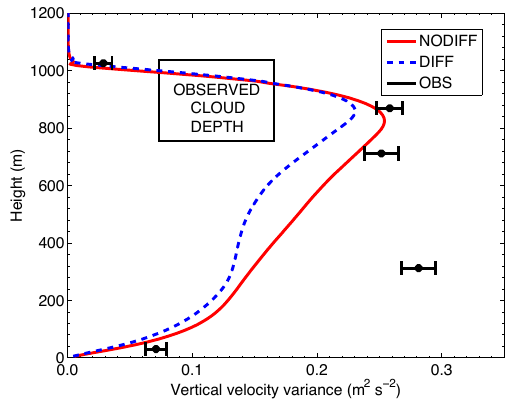
Fig. 2. Comparison of resolved-scale flux profiles between CIRPAS in-situ observations (data points) and LES output (lines). Observa- tions show means (symbol) and computed errors (error bars) over each of the five flight legs. Errors are computed with propagation of measurement uncertainties in Table 2. LES output are domain- averaged and temporally averaged over the sixth hour of simulation. Times of observations and LES output